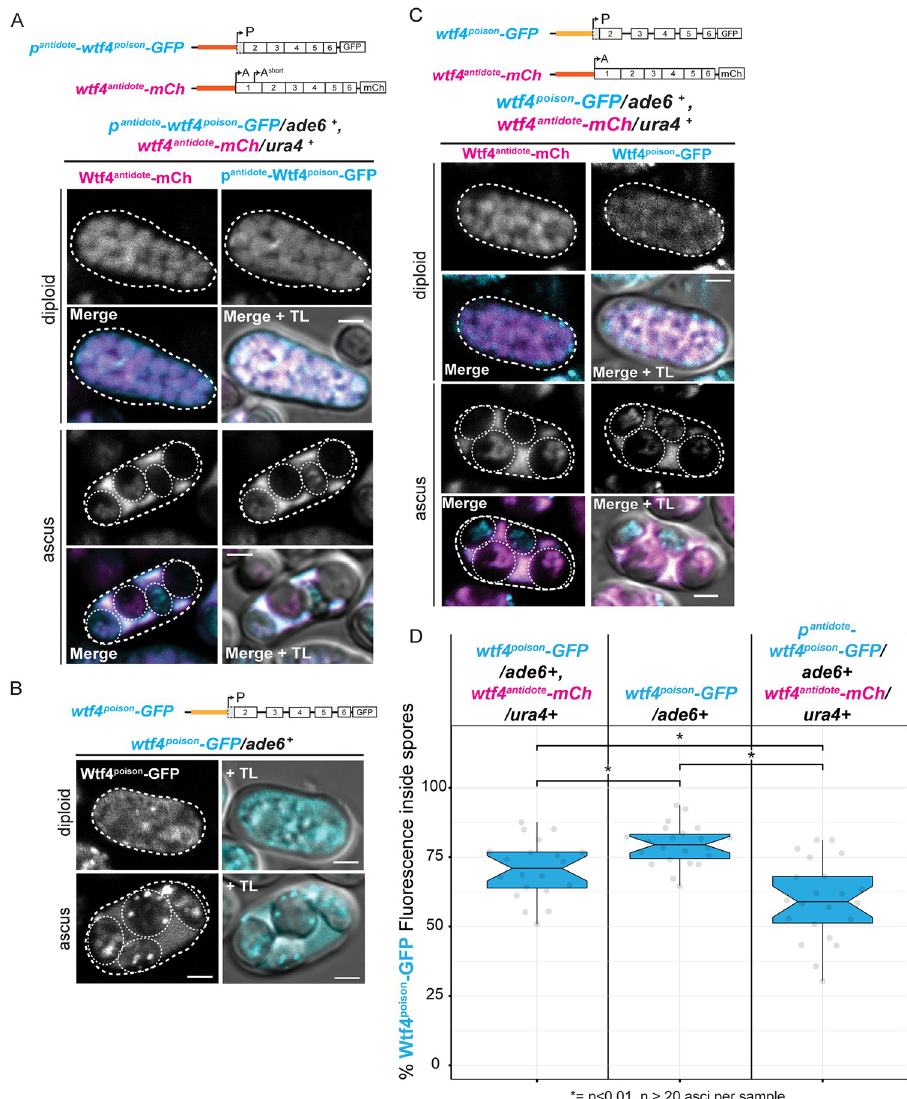
Fig 5. Wtf4 poison localization is altered when expressed from the p antidote promoter. ( A ) Image of a p antidote - wtf4 poison -GFP/ ade6+ , wtf4 antidote -mCherry/ura4+ diploid and tetratype ascus. p antidote -Wtf4 poison -GFP is shown in cyan and Wtf4 antidote -mCherry is shown in magenta in merged images. Additional images (parental ditype and non- parental ditype) can be found in S9B Fig. ( B ) Image of a wtf4 poison -GFP/ ade6+ diploid and ascus. Images of this strain were first presented in [37]. ( C ) Images of a heterozygous wtf4 antidote -mCherry/ura4+ , wtf4 poison -GFP/ade6+ diploid and ascus. Wtf4 antidote -mCherry is shown in magenta and Wtf4 poison -GFP is shown in cyan in merged images. Images of this cross are also depicted in Fig 1E. ( D ) Quantification of the percent of total ascal Wtf4 poison -GFP fluorescence located outside spores in asci generated by the following diploids: 1. wtf4 poison -GFP/ade6+ , wtf4 antidote -mCh/ura4+ , 2. wtf4 poison -GFP/ade6+ , and 3. p antidote -wtf4 poison -GFP/ade6+ , wtf4 antidote -mCh/ura4+ ( � = p < 0.01, t-test, n > 20 asci per sample). TL = transmitted light. All scale bars represent 2 μ m. All images were acquired after 2 days on sporulation media. Images were taken using the same settings. Not all images are shown at the same brightness and contrast to avoid over saturation of pixels in the brighter images. from its endogenous promoter (Fig 5A and 5B). Consistent with our hypothesis, we found that less of the total Wtf4 poison -GFP signal was inside of spores when the protein was expressed from the p antidote promoter, as compared to when the protein was expressed from the endoge- nous p poison promoter (59 vs 71%). We also noticed that less Wtf4 poison -GFP (from the